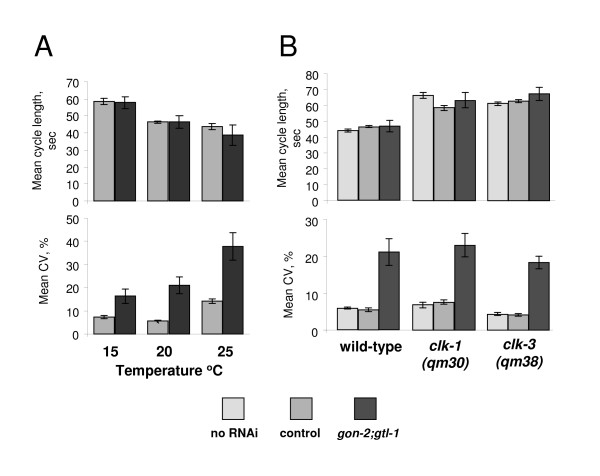
The variability and mean of the defecation cycle can be altered independently. The mean of the defecation cycle was perturbed using environmental and genetic approaches. A: The effect of temperature on wild type and gon-2(RNAi);gtl-1(RNAi) animals. The mean period and mean of the C.V. are shown. Worms were grown and assayed at the test temperature. B: The effect of genetic mutations, clk-1 and clk-3, which alter the mean. For each genotype we assayed untreated worms (labelled no RNAi), worms that had been injected with dsRNA for the E. coli cat gene (control) and worms injected with dsRNA for gon-2 and gtl-1. The mean cycle length and the mean of the C.V. are shown. Error bars are SEM in all panels.